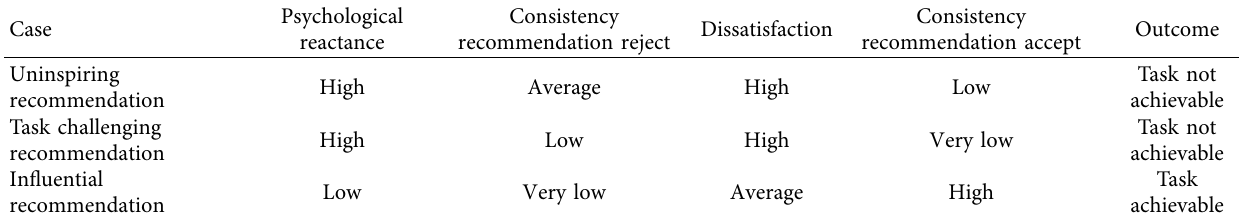
Table 5: Summary of the three Selected Model